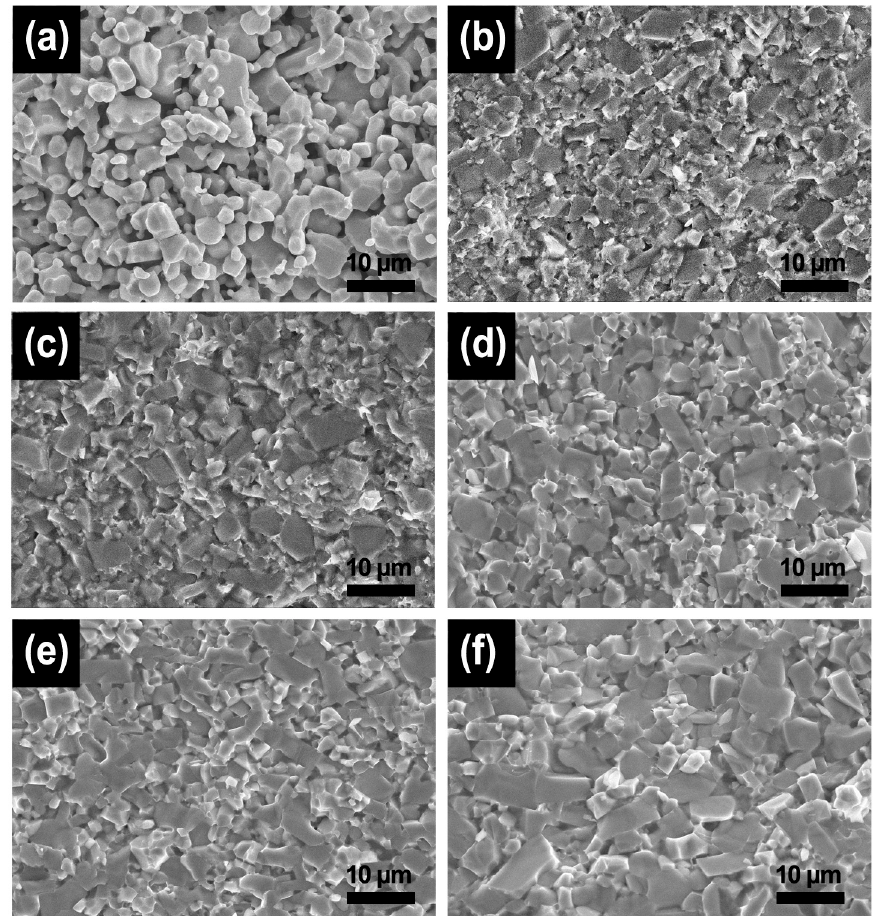
Figure 4. SEM images of ( a ) pure TiB 2 sintered at 1700 °C and ( b – f ) TiB 2 with 5 wt. % CoCrFeNiAl high-entropy alloy addition under different temperatures: ( b ) 1500 ◦ C; ( c ) 1550 ◦ C; ( d ) 1600 ◦ C; high-entropy alloy addition under different temperatures: ( b ) 1500 °C; ( c ) 1550 °C; ( d ) 1600 °C; ( e ) 1650 ◦ C; ( f ) 1700 ◦ ( e ) 1650 °C; ( f ) 1700 °C.